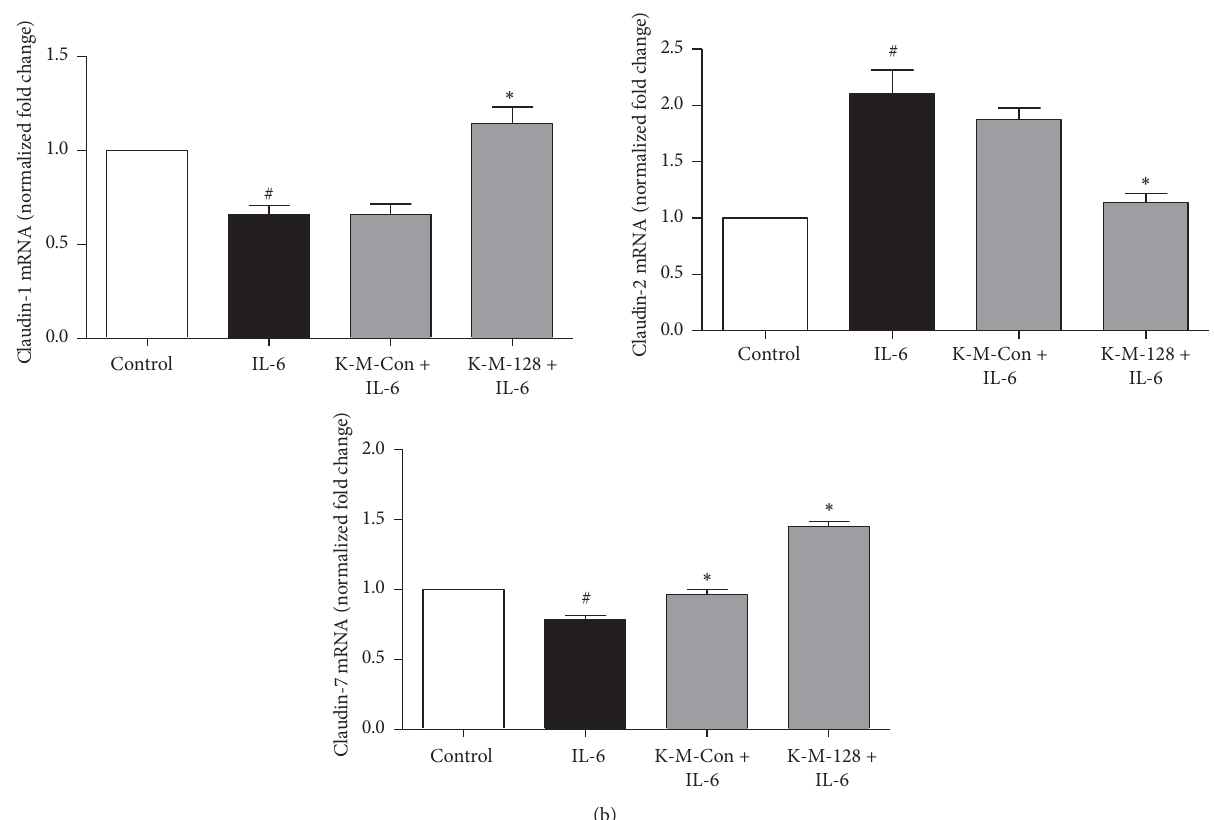
Figure 4: Effects of KIOM-MA/MA128 on the mRNA and protein expression of TJ proteins in the Caco2 monolayer. Caco2 monolayer cells were pretreated with 400 𝜇 g/ml KIOM-MA/MA128 1h prior to IL-6 (50 ng/ml) exposure for 24 h. (a) Cells were lysed, and the lysates were examined via Western blot for ZO-1, occludin, and claudin-2. Pretreatment with KIOM-MA/MA128 protected the TJ proteins. (b) Total mRNA was isolated, and the mRNA levels of TJ proteins, such as ZO-1, ZO-2, and ZO-3, occludin, and claudin-1, claudin-2, and claudin-7, were assessed. Pretreatment with KIOM-MA/MA128 protected the IL-6-induced mRNA expression. The results are reported as the means ± SDs from 3 independent experiments. ∗ 𝑝 < 0.05 compared with the IL-6 treated group; # 𝑝 < 0.05 compared with the control